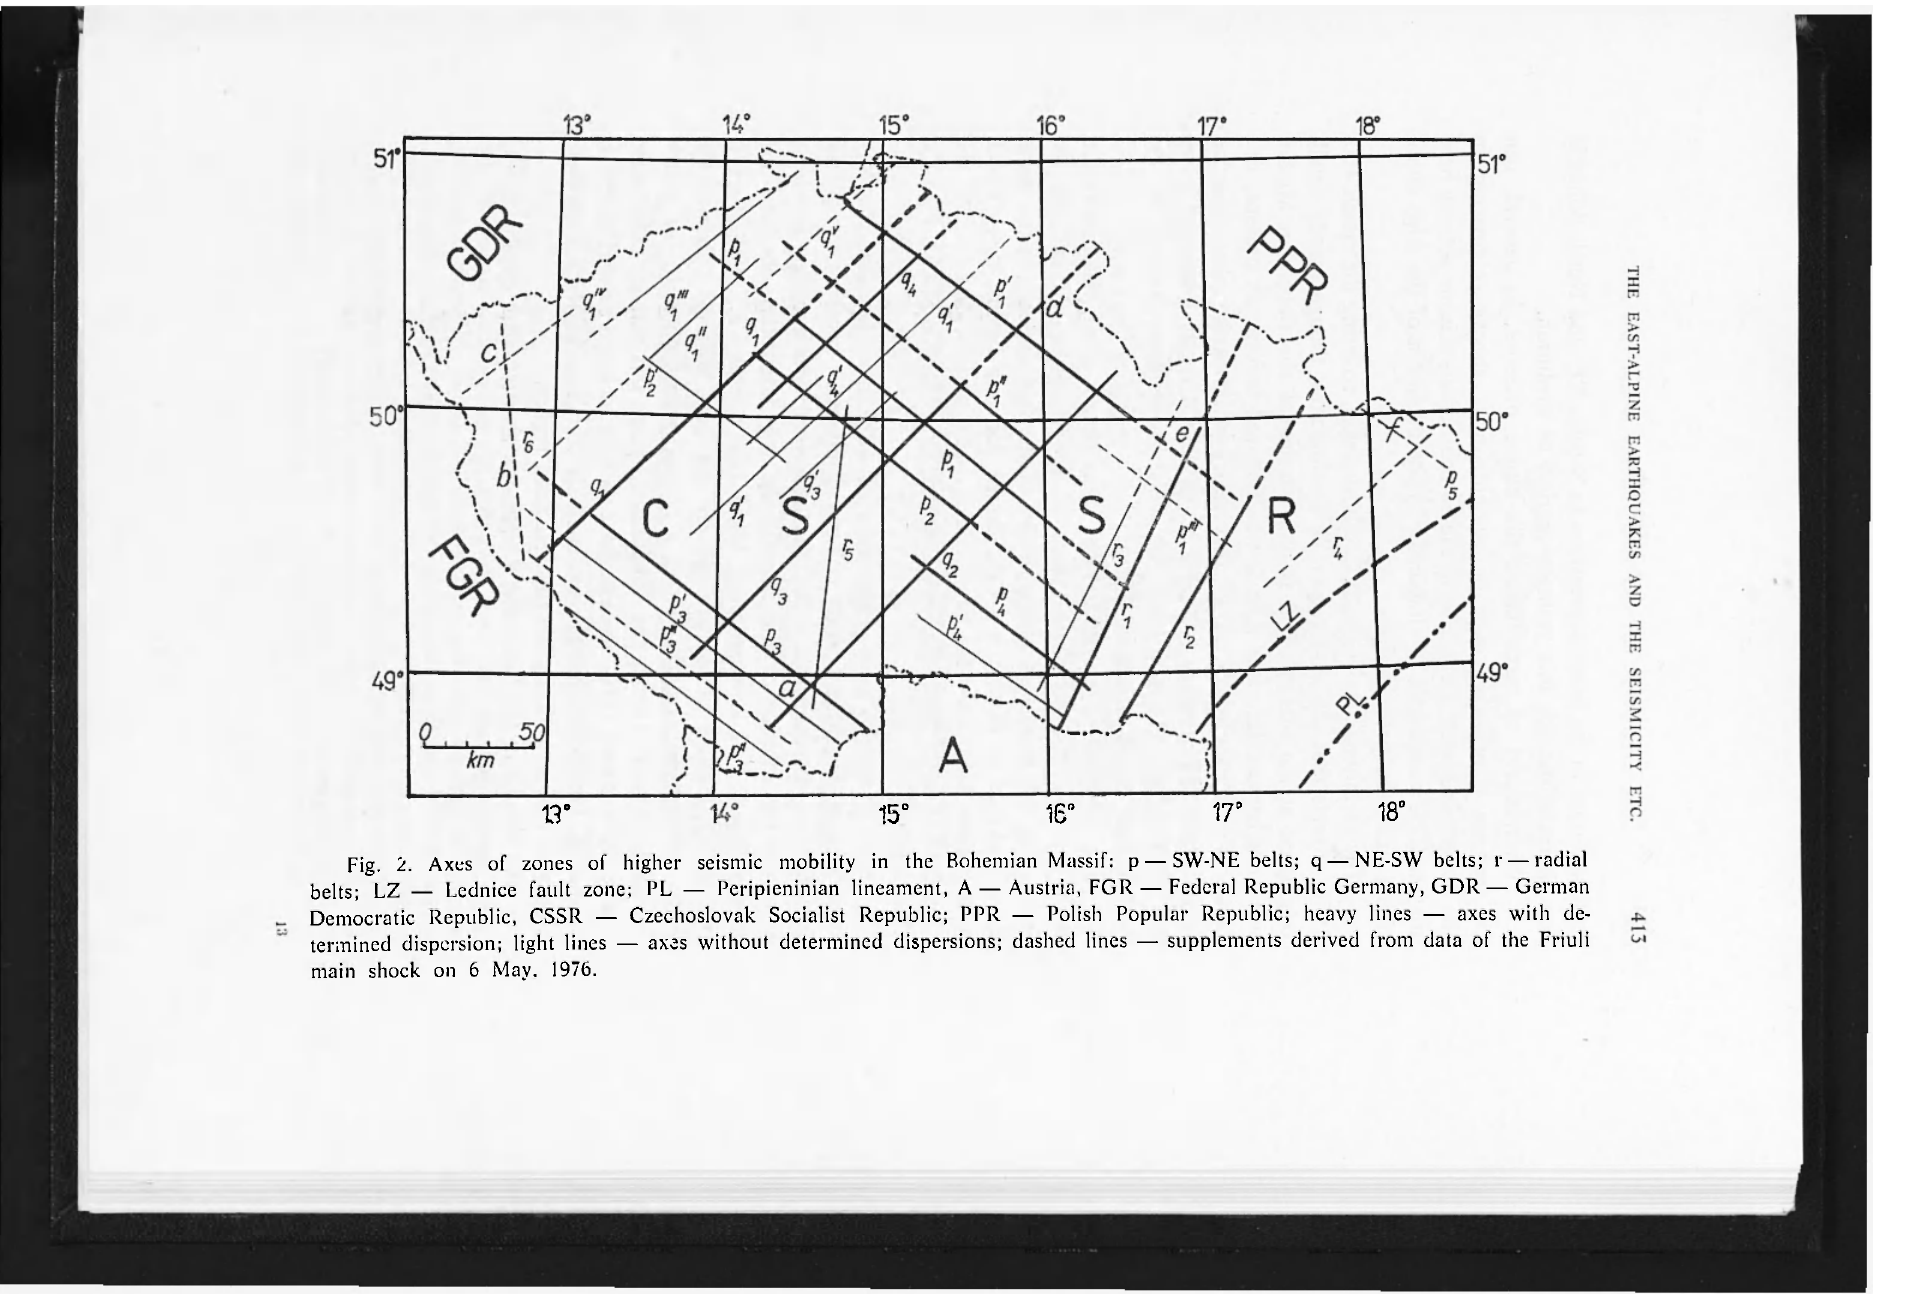
Fig. 2. Axes of zones of higher seismic mobility in the Bohemian Massif: p — SW-NE belts; q — NE-SW belts; r — radial belts; LZ — Lednice fault zone; PL — Peripieninian lineament, A — Austria, FGR—Federal Republic Germany, G D R — G e r m an Democratic Republic, CSSR — Czechoslovak Socialist Republic; PPR — Polish Popular Republic; heavy lines — axes with de- termined dispersion; light lines — axes without determined dispersions; dashed lines — supplements derived from data of the Friuli main shock on 6 May,